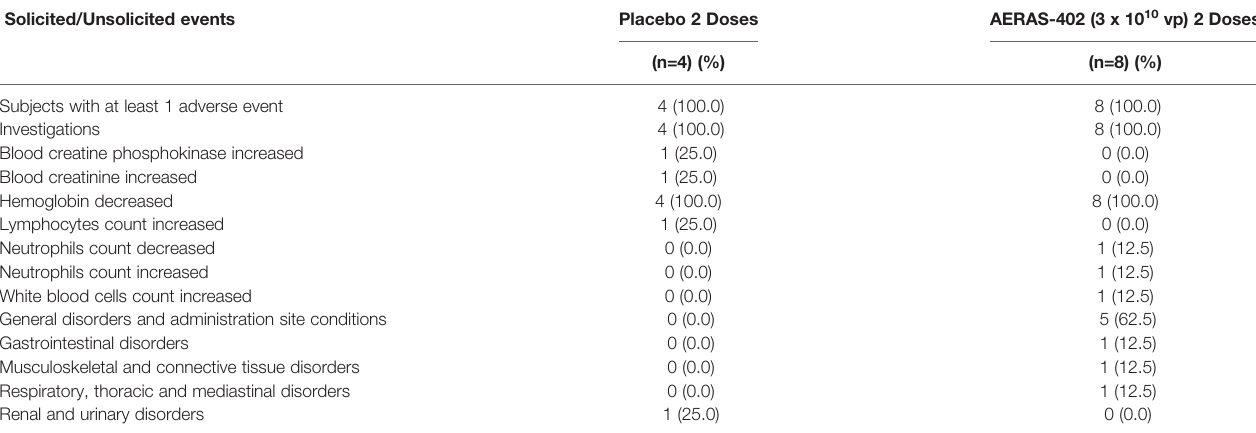
TABLE 2 | Number of subjects (%) with AEs for study day 0 or 28 post-vaccination. Solicited/Unsolicited events Placebo 2